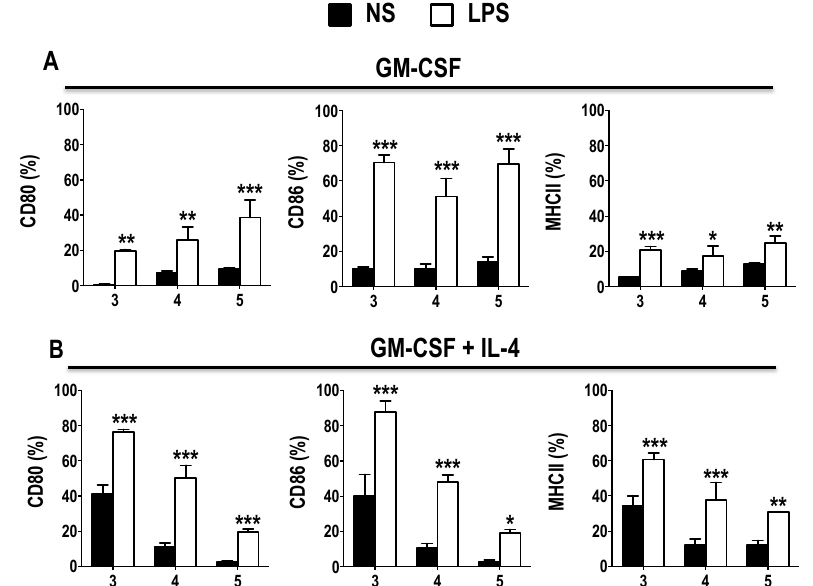
Figure 5. Expression of activation markers after stimulation with the TLR4 ligand LPS on DCs from early GM-CSF +/ - IL-4 cultures. Day 3 to 5 DCs were stimulated with LPS for 24 h. The expression of CD80, CD86 and MHCII on ( A ) GM-CSF and ( B ) GM-CSF + IL-4 derived DCs were measured using flow cytometry. Results shown are from 3 mice. Two-way ANOVA was used to compare both experimental conditions at each time-point. Results displayed as mean +/ − SD. * p < 0.05, ** p < 0.01, *** p < 0.001.